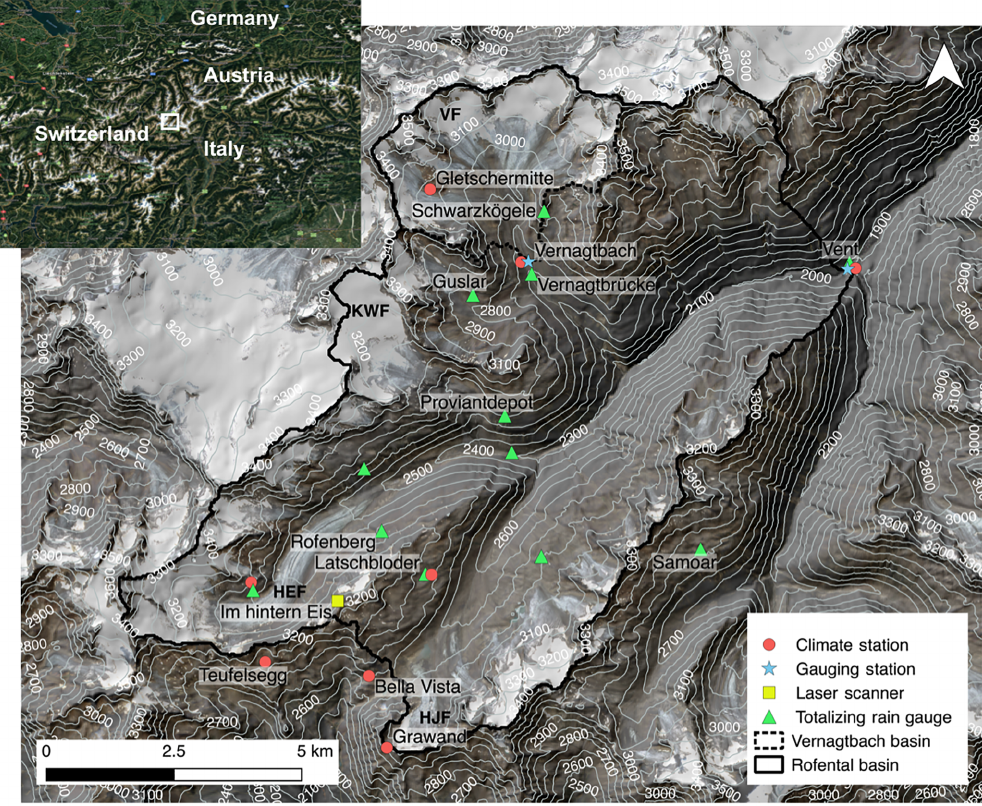
Figure 4. The Rofenache (98.1km 2 ) and Vernagtbach (11.44km 2 ) catchments with permanent meteorological stations and the runoff gauges. Background satellite image of the top left inset from maps.google.com, copyrights by Google (2009) and TerraMetrics